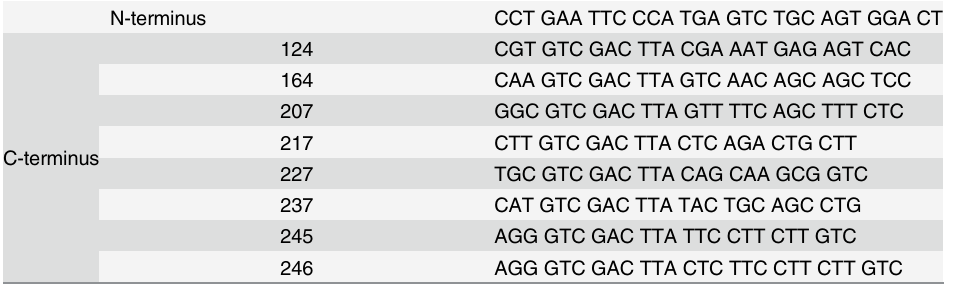
Table 1. Primer sequence for the generation of BAP31 deletion